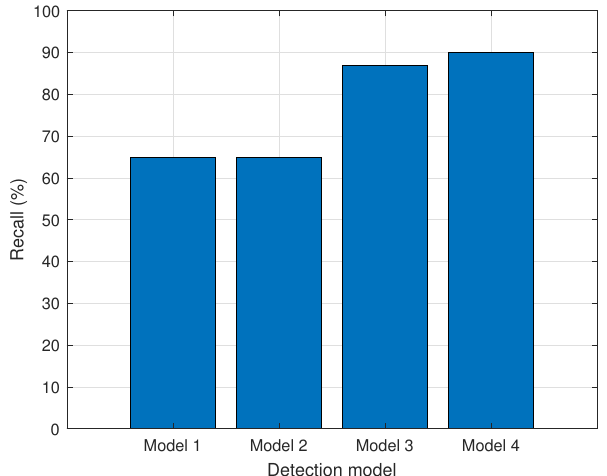
Figure 3. Recall for each recognition